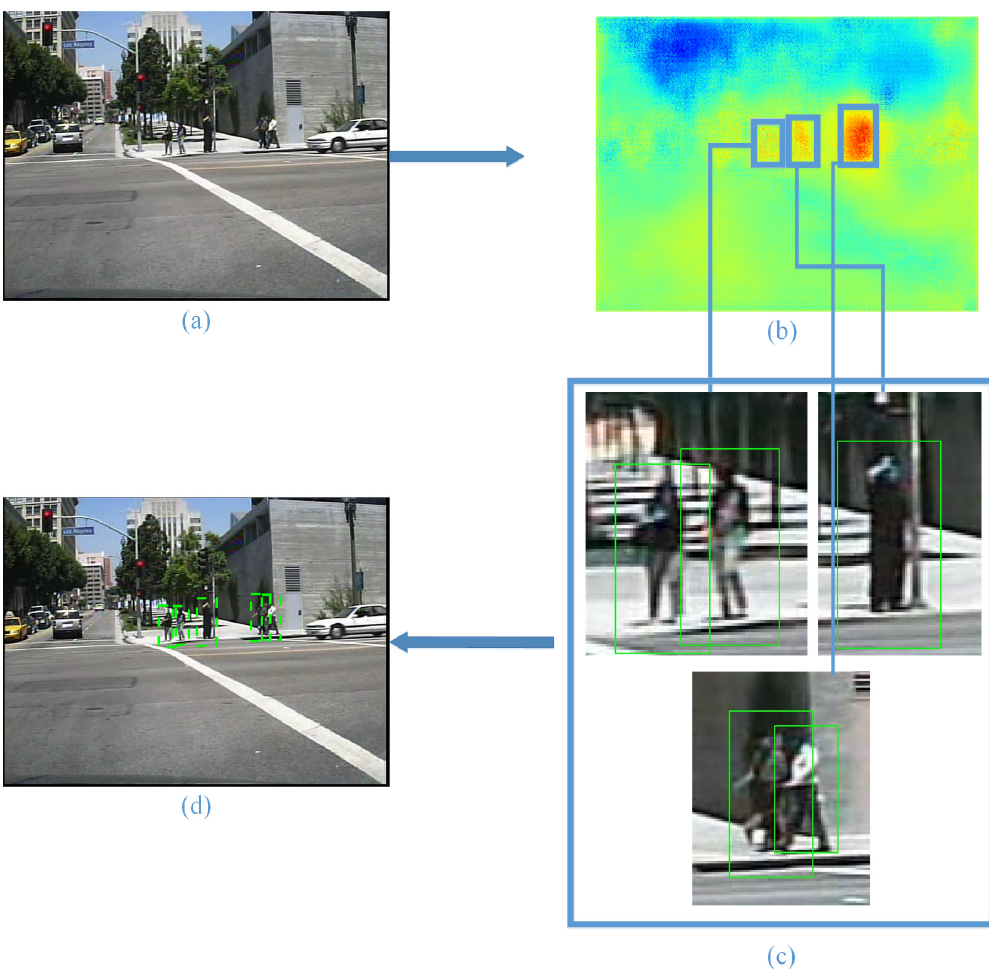
Figure 2. Key idea of our approach for pedestrian detection. ( a ) is the ordinary image, transferred to the heat map ( b ) with the deep neural network. The regions of interest are extracted from the heat map and then zoomed to the same scale. The HOG + SVM algorithm is used for pedestrian detection in the zoomed regions of interest ( c ). Finally, the detection results are mapped to the ordinary image ( d